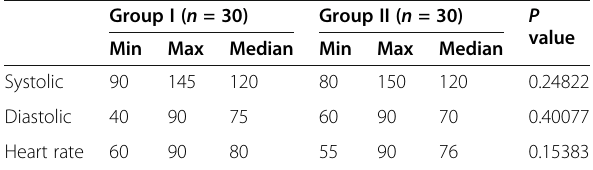
Table 2 Haemodynamic changes among the two groups